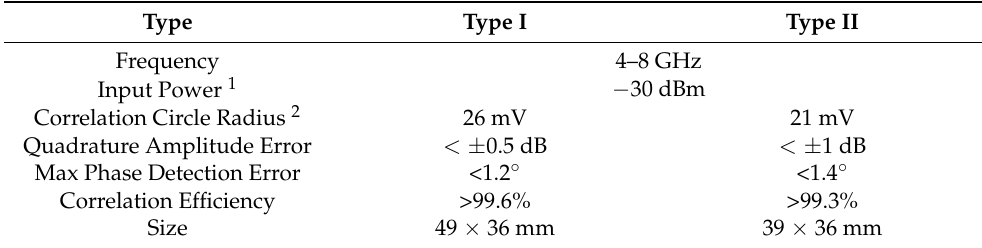
Table 1. Comparison between two types of correlators.